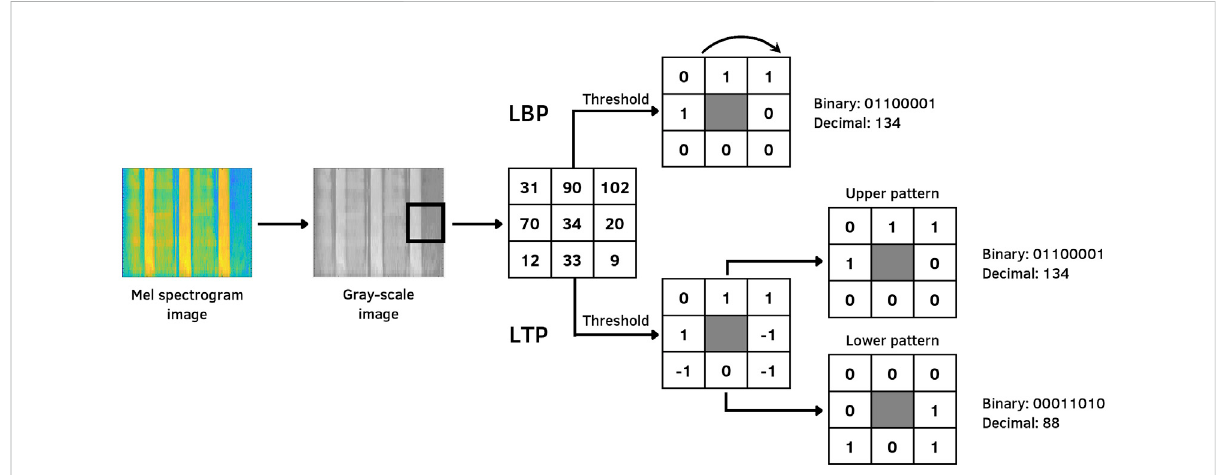
FIGURE 3 Example of LBP and LTP encoding from the Mel